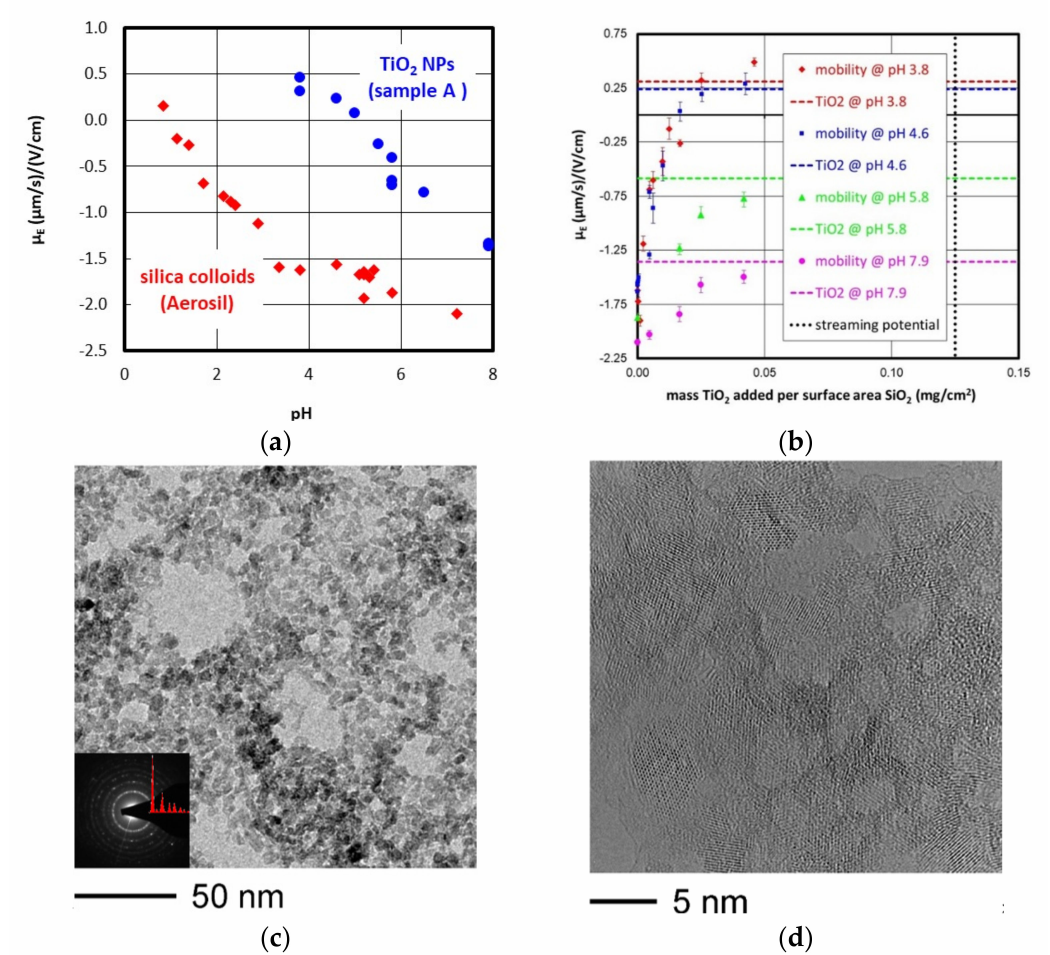
Figure 5. ( a ) Electrophoretic mobility of SiO 2 (AEROSIL OX 50) nanoparticles and TiO 2 NPs (Sample A) in the absence of the respective other sample as a function of pH in nominal 1 mM NaNO 3 electrolyte. ( b ) Electrophoretic mobility of AEROSIL OX 50 nanoparticles in the presence of TiO 2 NPs (Sample A) at selected pH values (represented by di ff erent colors) in 1 mM NaNO 3 electrolyte. The dashed horizontal lines correspond to the mobility values measured for bare Sample A TiO 2 NPs (in the absence of SiO 2 ) at the respective pH (indicated by the color). The vertical line corresponds to the condition under which the zeta-potential experiments with quartz (001) and Sample A were carried out. ( c ) Bright-field TEM overview image of Sample A TiO 2 NPs with an SAED pattern as inset. ( d ) HRTEM micrograph of the Sample A TiO 2